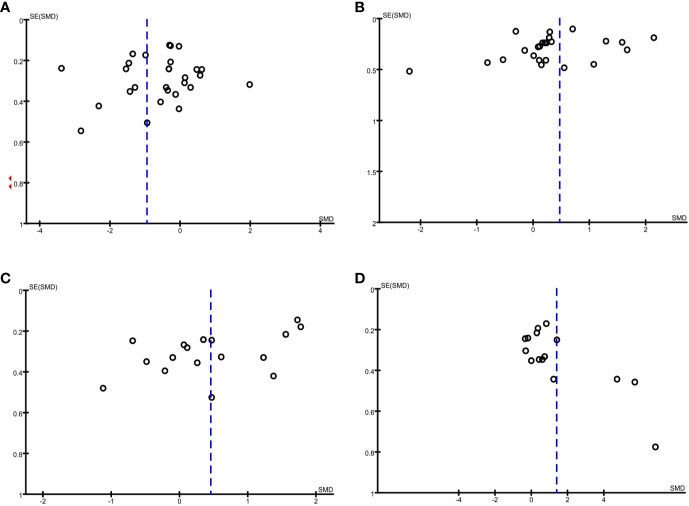
Funnel plot analysis to detect publication bias under a dominant model. (A) Funnel plot for adiponectin. (B) Funnel plot for leptin. (C) Funnel plot for resistin. (D) Funnel plot for visfatin.